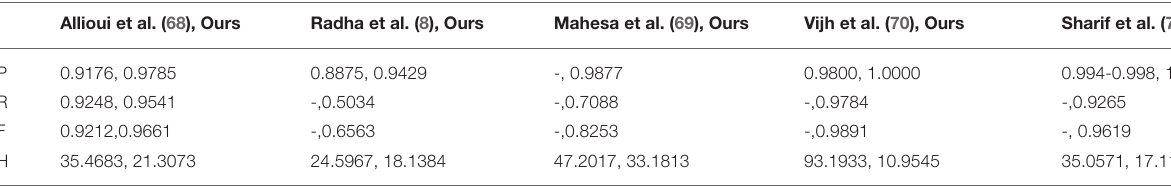
TABLE 6 | Evaluate parameters in test 3-part one.